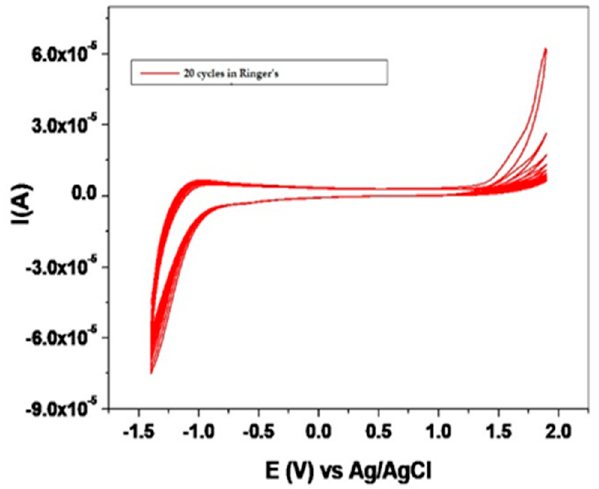
Figure 1. Voltammograms of 20 cycles in Ringer’s solution, temperature 25 °C, with a speed of 100 mV/s, for retrieved (patient 1) and new mini-implants.